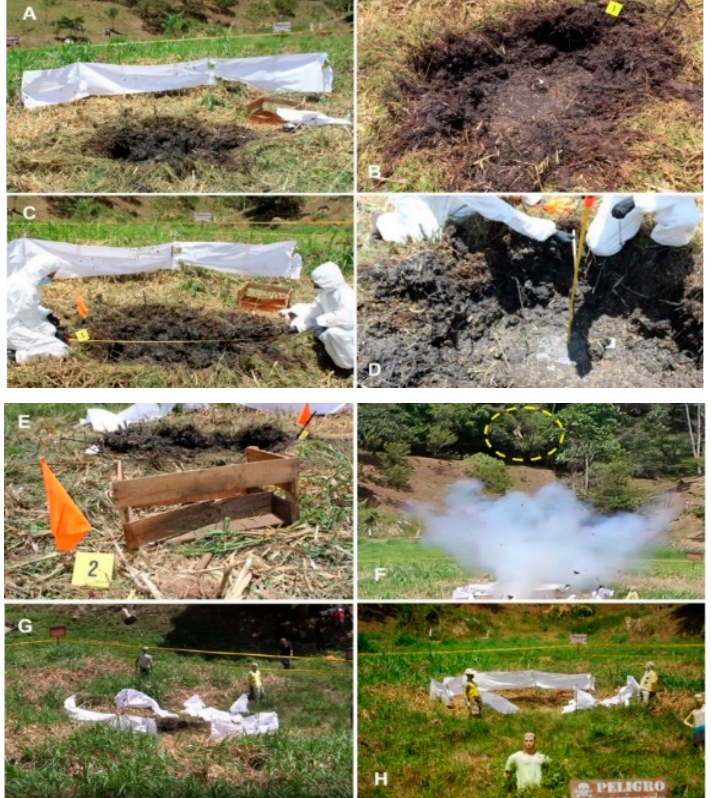
Figure 5. Effects of the shock wave on elements present in scene. ( A ) General view of the scene; ( B ) Crater; ( C , D ) Crater diameter and depth measurements, respectively; ( E ) Photograph showing the effects on the wooden box and its spatial relationship to the crater; ( F ) Part of the carcass ascending after the explosion (dotted yellow circle). It is possible to visualize dark solid particles moving in the direction of the camera (east position) in the smoke; ( G , H ) Degree of destruction of the fence registered from southern and eastern positions, respectively.